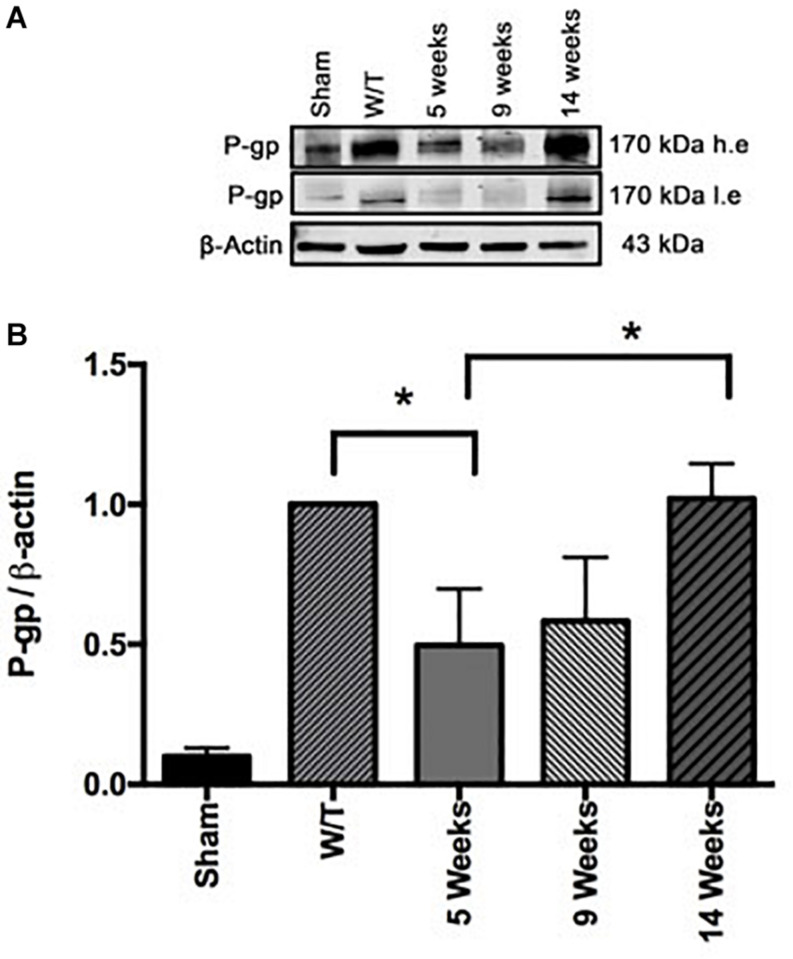
(A) Comparison of the levels of P-gp (determined by Western Blot) in the sham-operated rats and two groups of implant-operated animals: one with no drug treatment (W/T) and the other given mifepristone/temozolomide (Mif/Tz) at 5 weeks post-surgery (corresponding to the end of the 3-week drug treatment), and 9, 14 weeks (corresponding to 4 and 9 weeks after the end of drug treatment), h.e., high exposure; l.e., low exposure. (B) The densitometer analysis (n = 3). Data represent the mean ± SD of three independent experiments. *Significant difference (p < 0.05) between the Mif/Tz rats at 5 and 14 weeks.